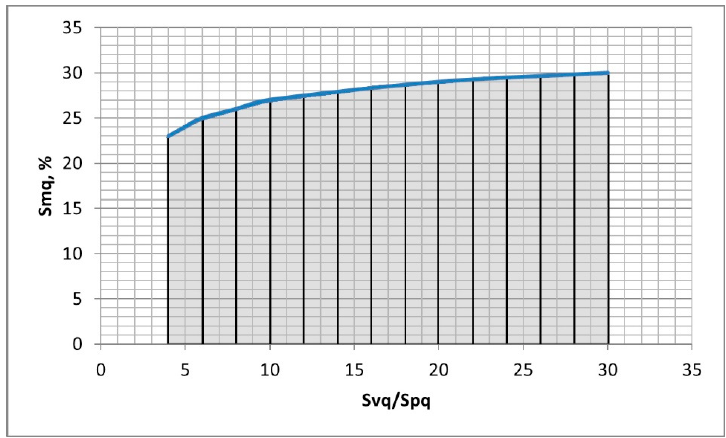
Figure 7. Conditions of bimodal height distributions of two-process surfaces; bimodal distribution appears for the Smq parameter within the shaded area.